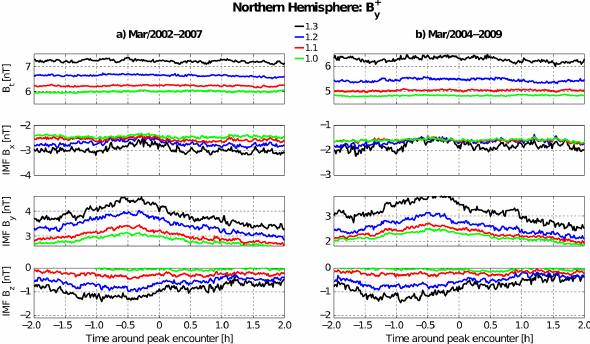
Fig. 5. The averaged profiles of (from top to bottom) the total mag- netic field B t and IMF B x , B y , and B z components for two periods: (a) March 2002–March 2007 and (b) March 2004–March 2009. The = 1 . 0, 1.1, 1.2, and 1.3. results are shown for IMF B + y and for ρ thr rel